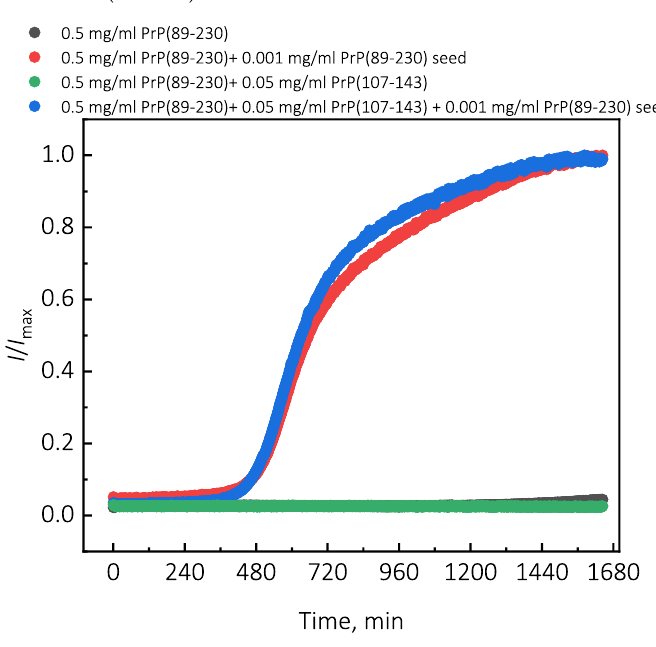
Figure A7. Representative curves of PrP(89-230) aggregation kinetics in the presence of monomeric PrP(107-143). For aggregation experiments, solutions of 0.5 mg/mL of monomeric PrP(89-230) in 0.5 M GuHCl, 50 mM phosphate buffer (pH 6), containing 50 µ M ThT were supplemented with either 0.001 mg/mL of PrP(89-230) seed, 0.05 mg/mL of PrP(107-143) monomers, or both 0.001 mg/mL of PrP(89-230) seed and 0.05 mg/mL of PrP(107-143) monomers. Aggregation reaction was performed under quiescent conditions at a 60 ◦ C temperature. Aggregation kinetics were monitored by ThT fluorescence assay (excitation at 470 nm, emission at 510 nm) using Qiagen Rotor-Gene Q real-time